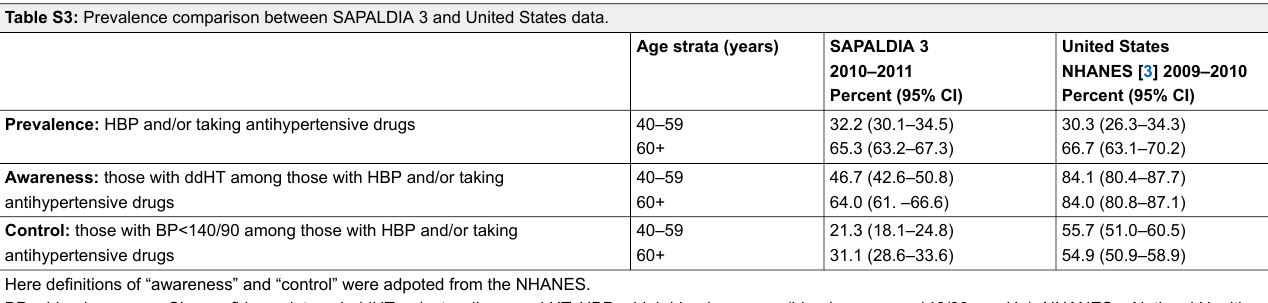
Table S3: Prevalence comparison between SAPALDIA 3 and United States